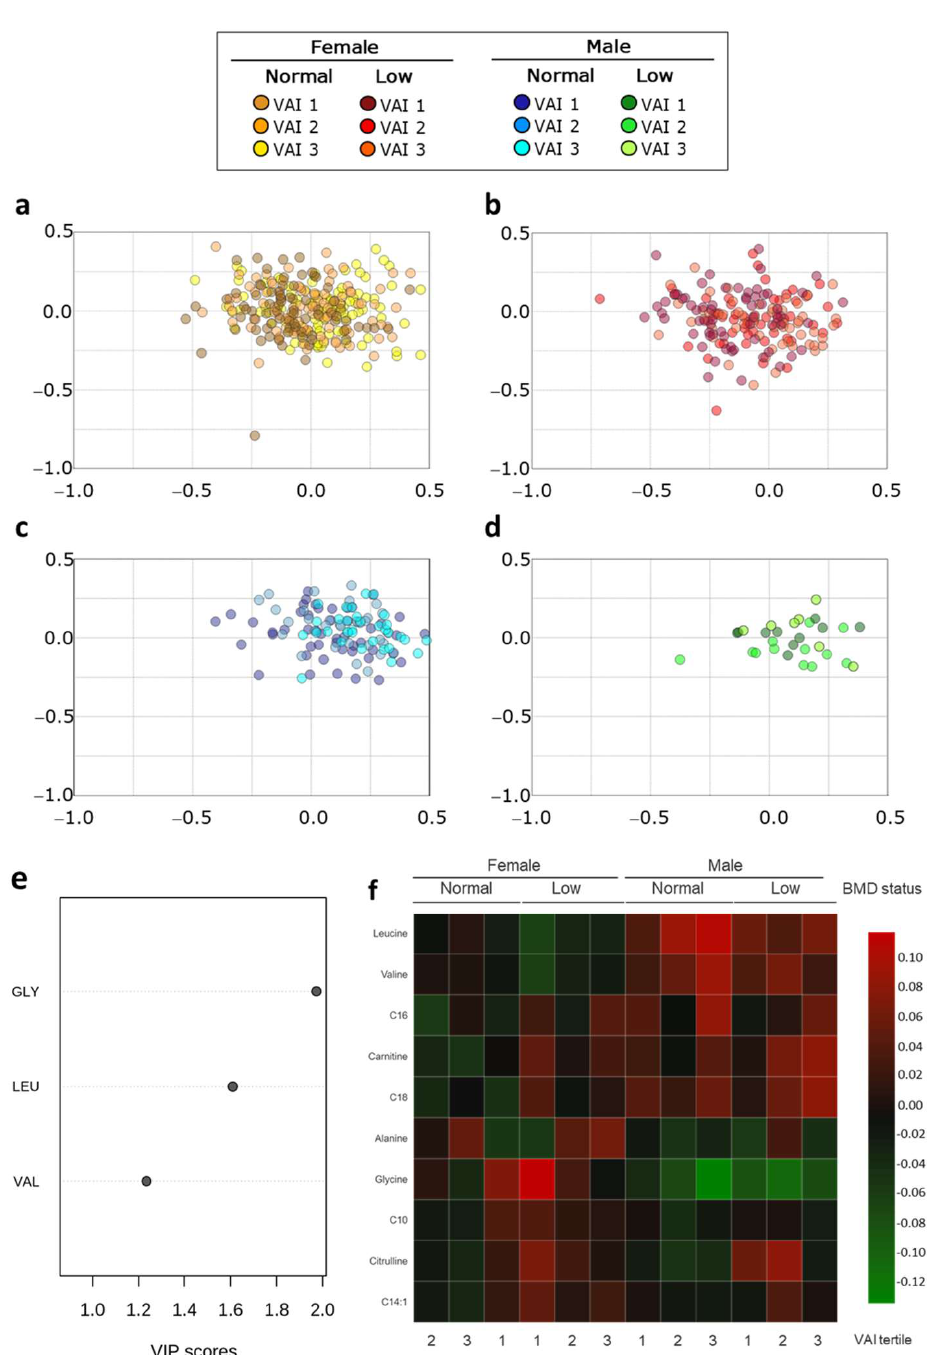
Figure 6. Metabolic profile according to sex-dependent VAI and BMD status. PLS-DA plot shows the separation between groups. The explained variances C1 = 26.3% and C2 = 18.8% (accuracy 0.21; R2 0.22; Q2 0.20: permutation p -value < 5.0 × 10 −4 ); ( a ) female; normal BMD VAI1-VAI3, ( b ) female; low BMD VAI1-VAI3, ( c ) male; normal BMD VAI1-VAI3, ( d ) male; low BMD VAI1-VAI3. ( e ) VIP analysis represents the relative contribution of metabolites to the variance among the groups. A high VIP score indicates a greater contribution of the metabolites to the group separation. ( f ) Hierarchical heatmap, red and green, indicate increase and decreased concentration, respectively.